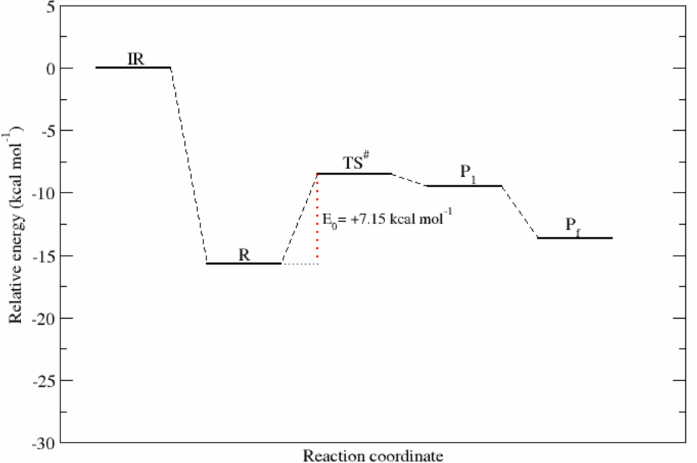
Figure 4. Reaction energies of the Gly-TS5 path with respect to isolated reactants as computed using ZPE corrected electronic energies in the SMD solvent